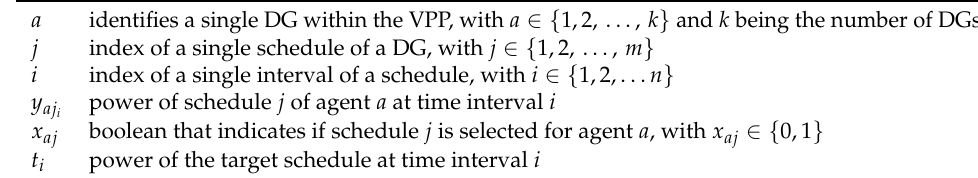
Table 1. Identifiers for the problem formulation in Equations (1) and